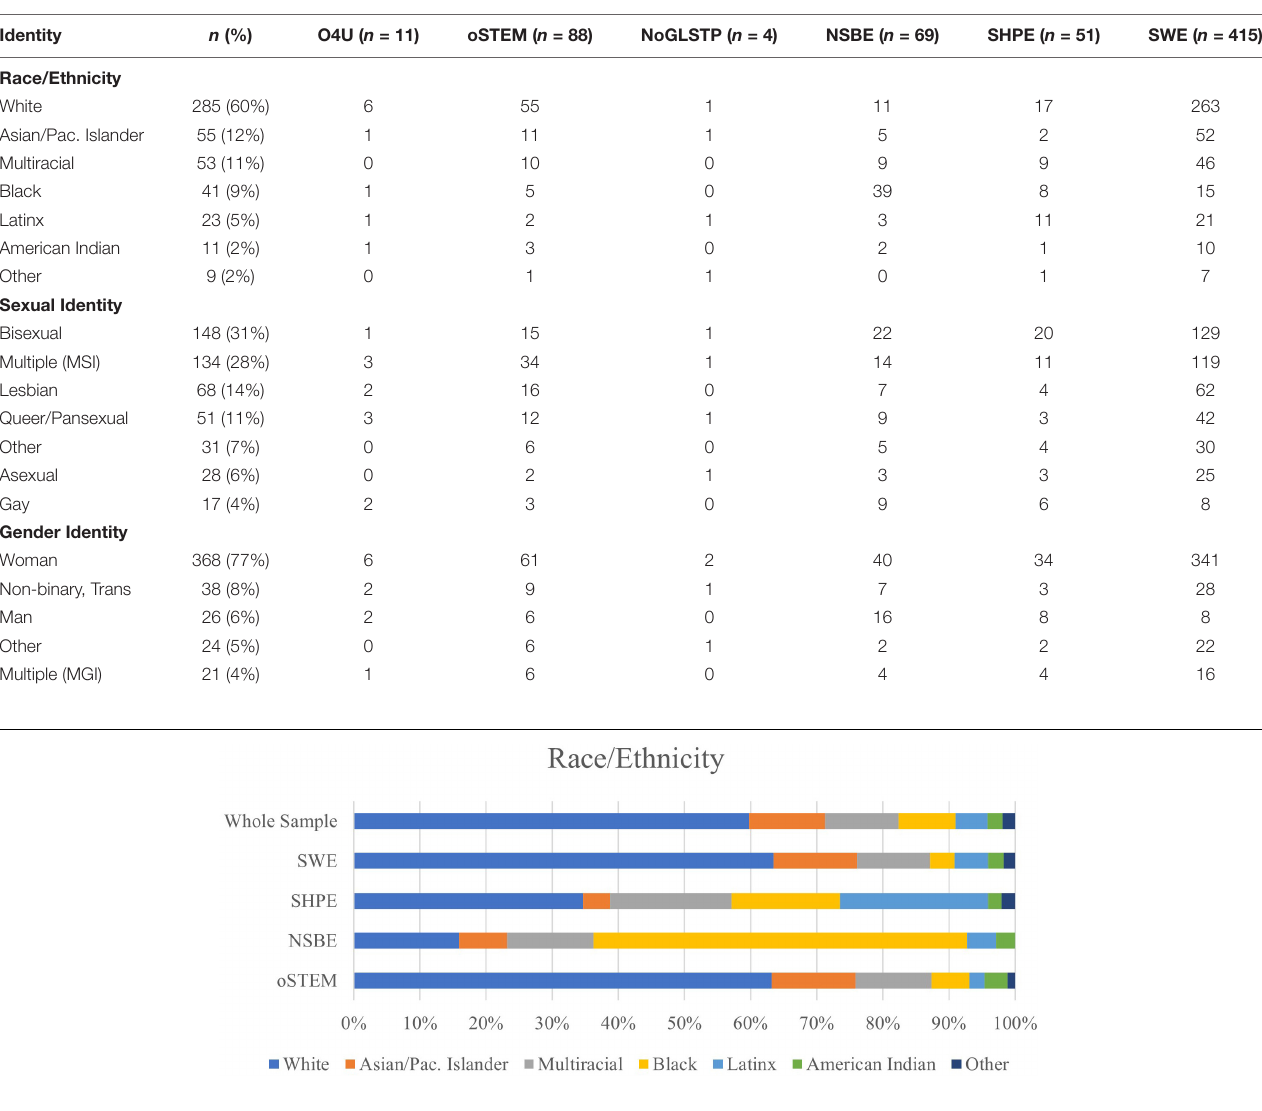
FIGURE 1 | Racial/ethnic identity of sample, SWE, SHPE, NSBE, and oSTEM members.